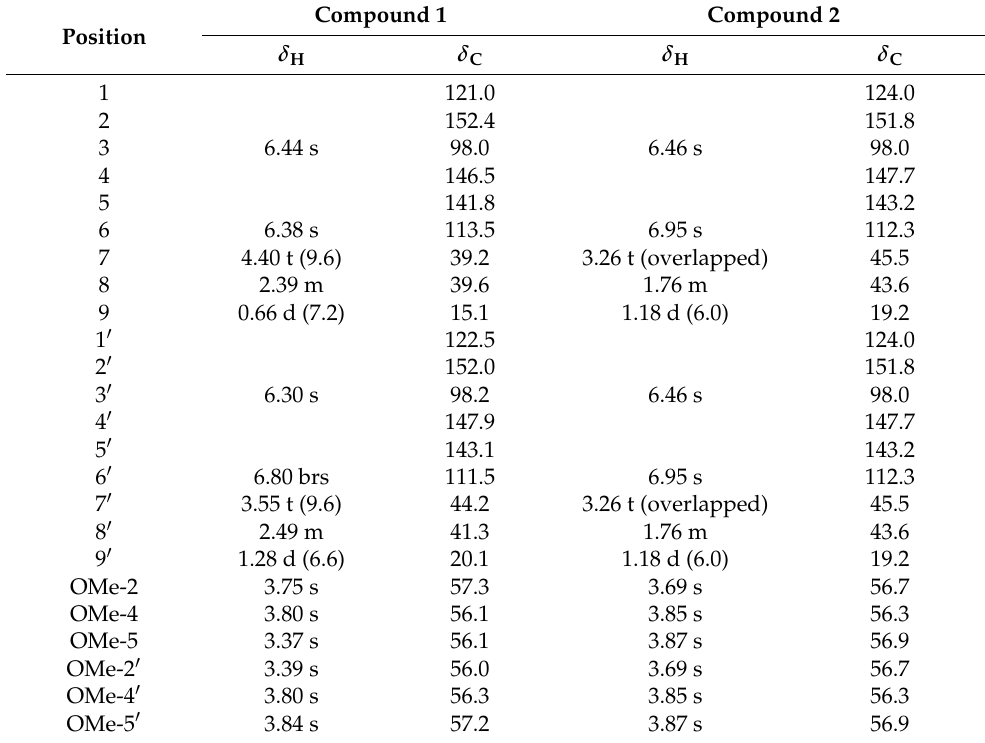
Table 1. The 1 H (600 MHz) and 13 C NMR (150 MHz) data of compounds 1 and 2 in CDCl 3 ( δ in ppm, J in